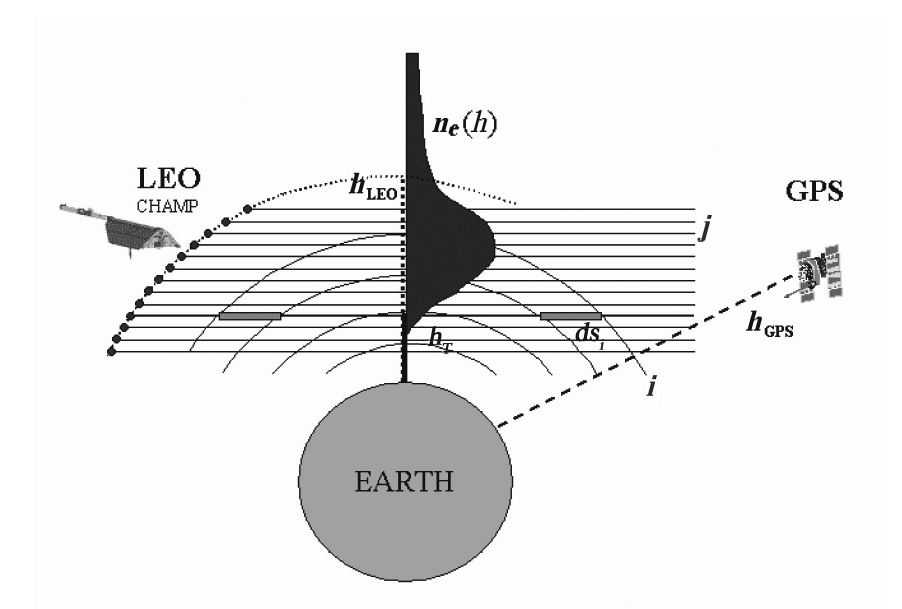
Fig. 7.3. Illustration of the retrieval technique used for CHAMP data